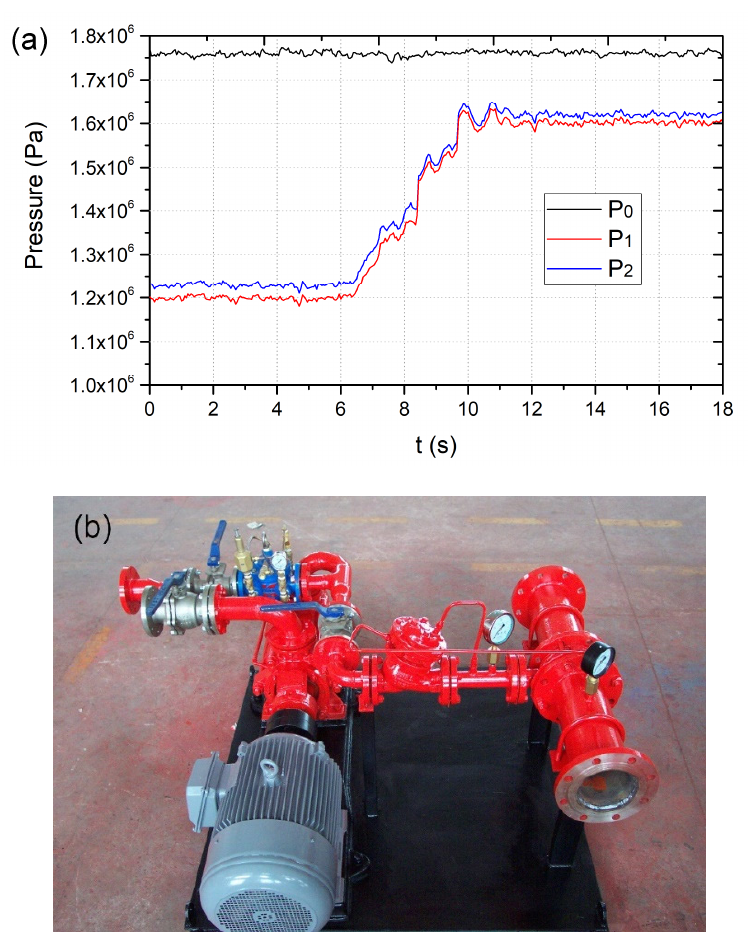
Figure 12. ( a ) Time history of measured pressure signals ( 𝑃 (cid:2868) , 𝑃 (cid:2869) , and 𝑃 (cid:2870) ) with 𝑞 (cid:3032) fixed at 8 L/s and 𝑃 (cid:2869) varied from 1.2 to 1.6 MPa; ( b ) the developed IBPP unit—BPPH6/150 series. varied from 1.2 to 1.6 MPa; ( b ) the developed IBPP unit—BPPH6 / 150